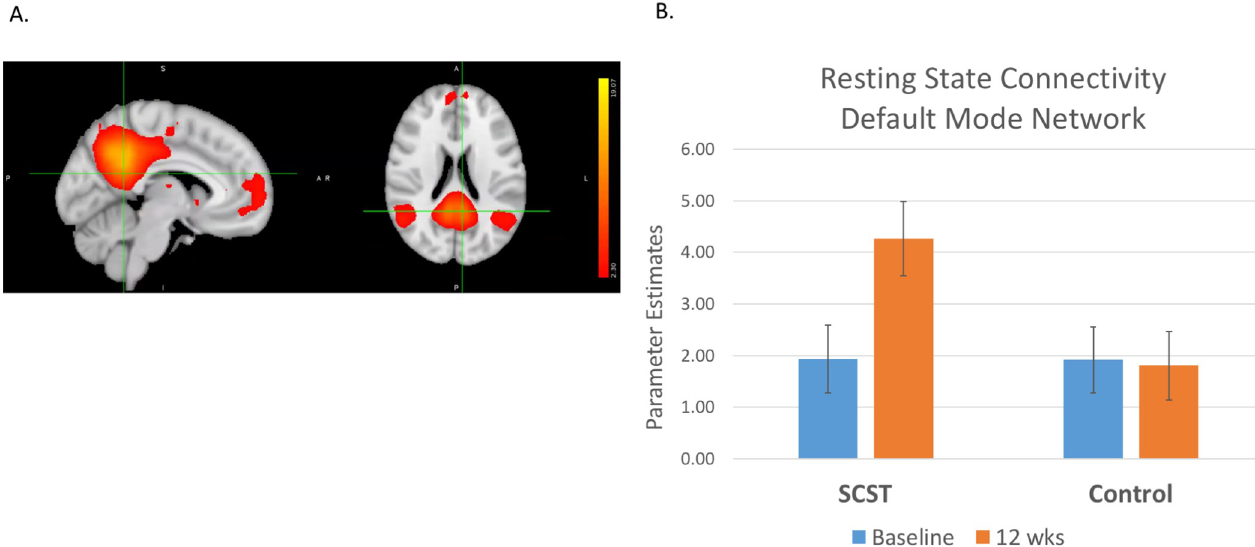
Fig 2. Intrinsic functional connectivity. A) default mode network component identified from rsfMRI data across groups. Cross-hairs centered on MNI coordinates: x = -6, y = -50, z = 21. B) this figure illustrates a group by interaction shown in the analysis using randomise.